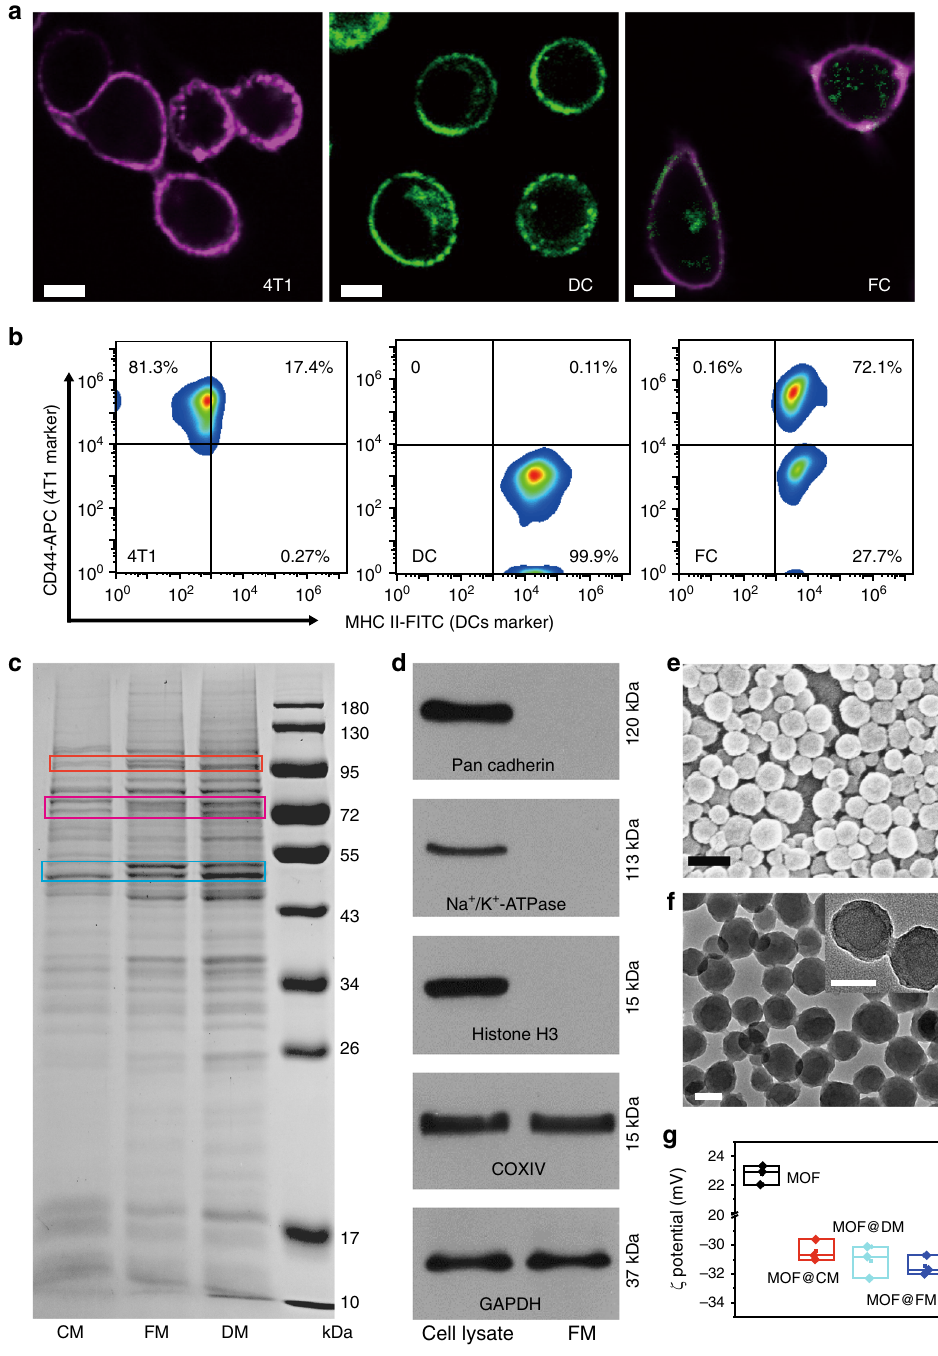
Fig. 2 Characterization of FM and MOF@FM. a Fusion of DCs and 4T1 cells by CLSM observation over red fl uorescence of anti-CD44-APC antibody marked 4T1 and green fl uorescence of anti-MHC II-FITC antibody labeled DCs, and the double-labeled FCs. Scale bar = 10 μ m. b Flow cytometric analyses of anti-CD44-APC antibody marked 4T1 cells, anti-MHC II-FITC antibody labeled DCs and the double-labeled FCs. c SDS-PAGE protein analyses of CM, DM, and FM. d Western blotting analysis of membrane-speci fi c and intracellular protein markers in the FCs lysate and FM. e SEM image of MOF. Scale bar = 200 nm. f TEM images of MOF@FM. Scale bar = 100 nm. g Zeta potentials of MOF, MOF@CM, MOF@DM and MOF@FM. Measurements were taken from distinct samples ( n = 3). Source data are provided as a Source Data fi